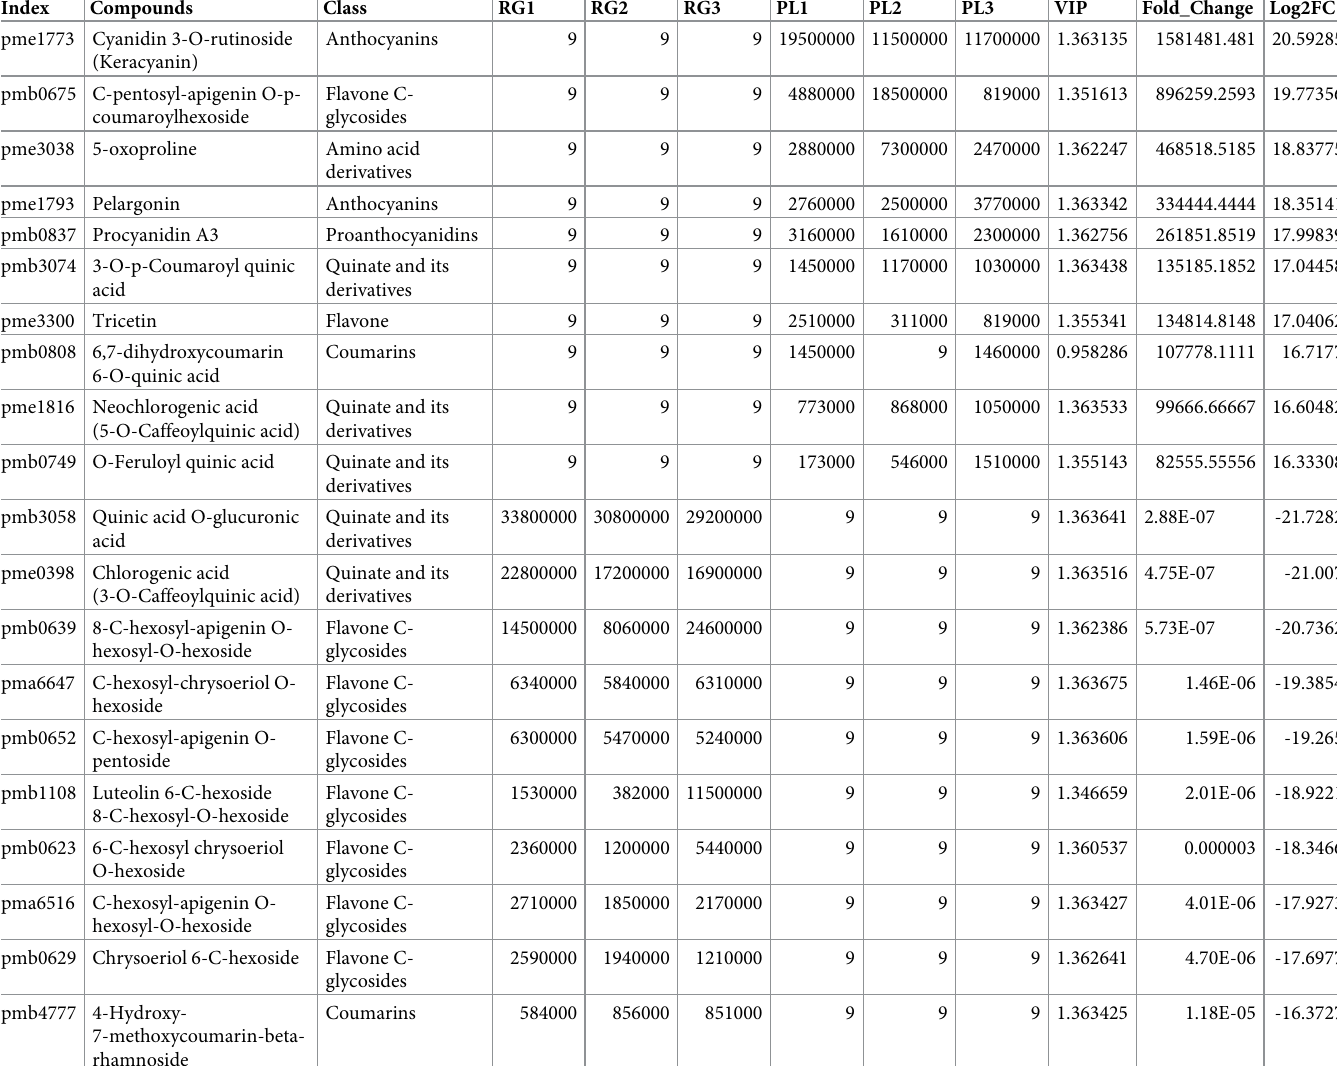
Table 1. List of top 10 up- and downregulation metabolites in PL vs RG. Differentially expressed proteins were defined as those with a variable importance for projec- tion (VIP) value >